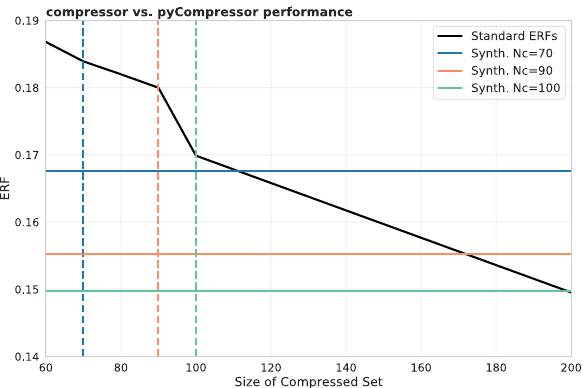
Fig. 11 Comparison of the performance of the new generative-based compression algorithm (synthetic) and the the previous methodology (standard). The normalized ERF values of the standard compression are plotted as a function of the size N c of the compressed set (solid black line). The dashed blue, orange, and green lines represent N c = 70 , 90 , 100 respectively. The solid lines represent the corresponding ERF values of the enhanced compression